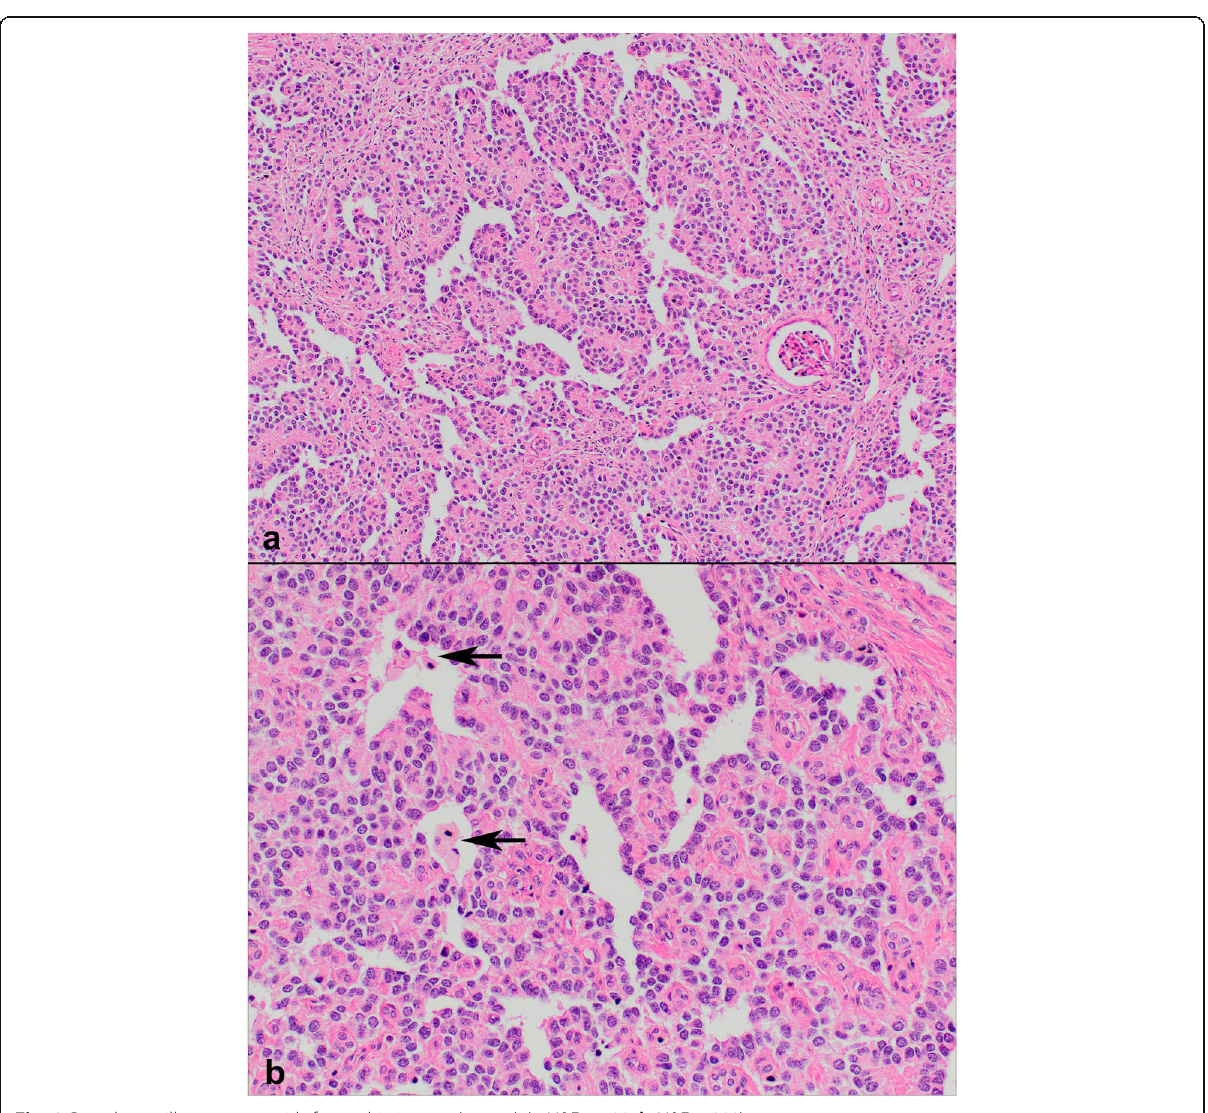
Fig. 3 Pseudo-papillary pattern with foamy histiocytes (arrows) ( a H&E × 100; b H&E ×